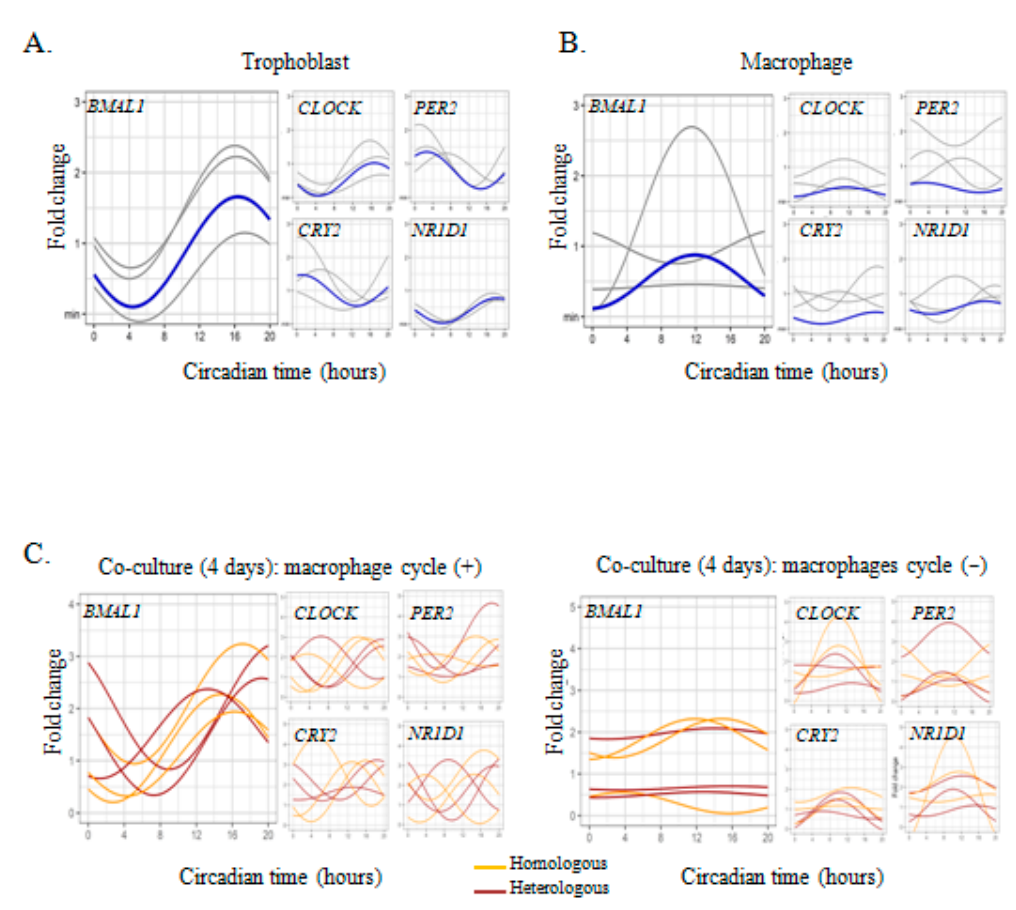
Figure 2. Circadian clock genes expression in macrophages co-cultured with trophoblasts. ( A , B ) Trophoblasts and macrophages were isolated from placentas from 3 healthy women and cultured for 4 days. Each sinusoid (in gray) represents the expression of the clock genes over time for each donor after adjustment of the values by the cosinor model (mean of 3 technical replicates for each donor). The mean of the fold change of biological replicates is represented in blue. ( C ) Macro- phages ( n = 6) were co-cultured with trophoblasts, in autologous (orange) or heterologous (brown) condition, for 4 days and the expression of clock genes was evaluated by qRT-PCR every 4 h for 24 h and expressed in fold change from the maximum value. Each sinusoid represents the expression of the clock genes over time for each donor after adjustment of the values by the cosinor model (mean of 3 technical replicates for each donor). The statistical analysis was performed using the cosinor function using R studio (v3.4.0, Boston, USA).